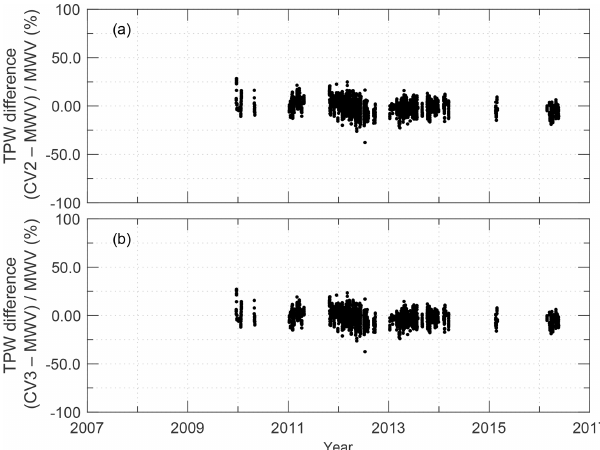
Figure 13. Time series of the relative differences between (a) level 2.0 V2 TPW from Cimel sun photometer and the microwave ra- diometer, and from (b) level 2.0 V3 TPW from the Cimel sun pho- tometer, during the period